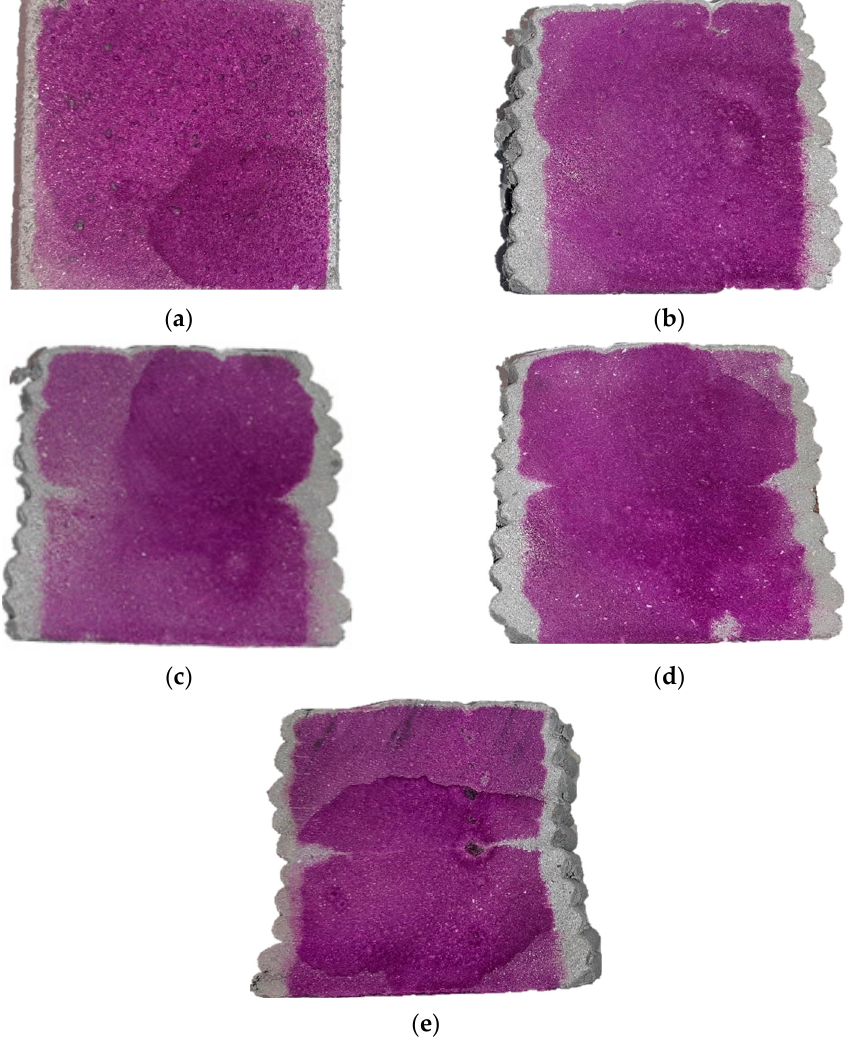
Figure 16. 12-week carbonation front for the C-V ( a ), 3D-0 ( b ), 3D-10 ( c ), 3D-20 ( d ) and 3D-30 ( e ) samples.